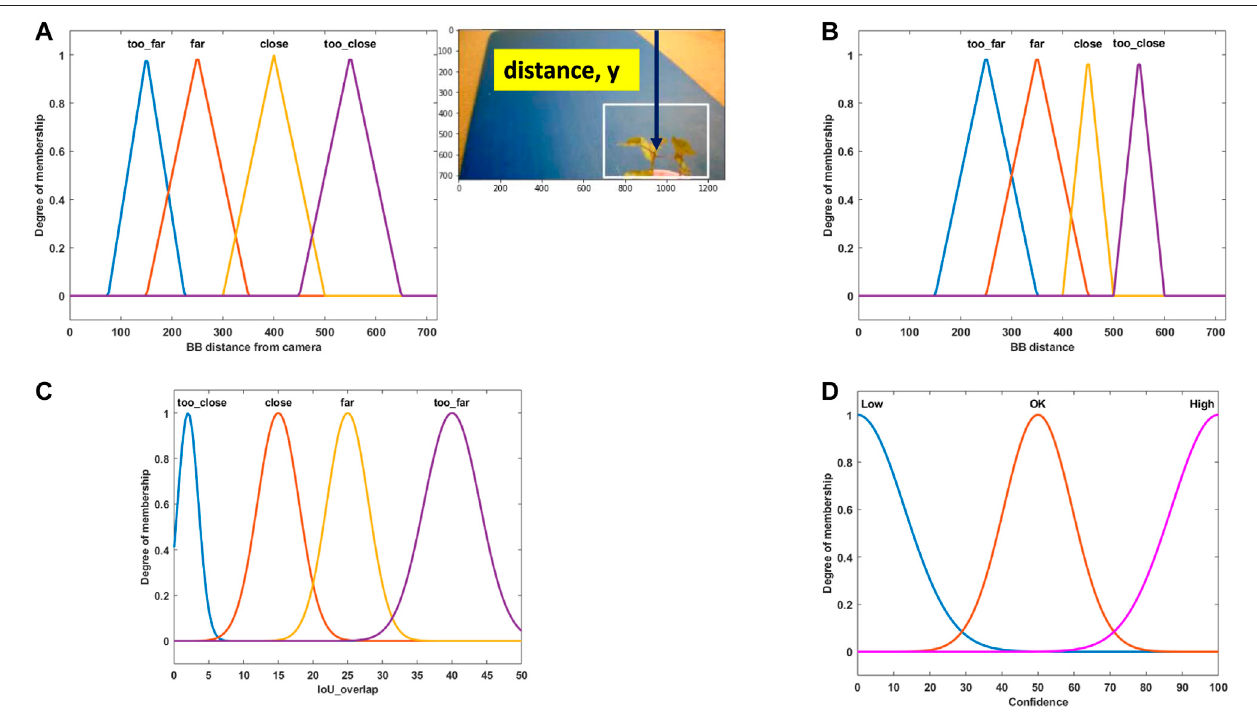
FIGURE 7 | (A) Fuzzy set for the weed bounding box distance in camera view for the right camera [Input]. (B) Fuzzy set for the weed bounding box distance in camera view for the left camera [Input]. (C) Fuzzy set for bounding box overlap between the left and right cameras [Input]. (D) Fuzzy set for fusion con fi dence